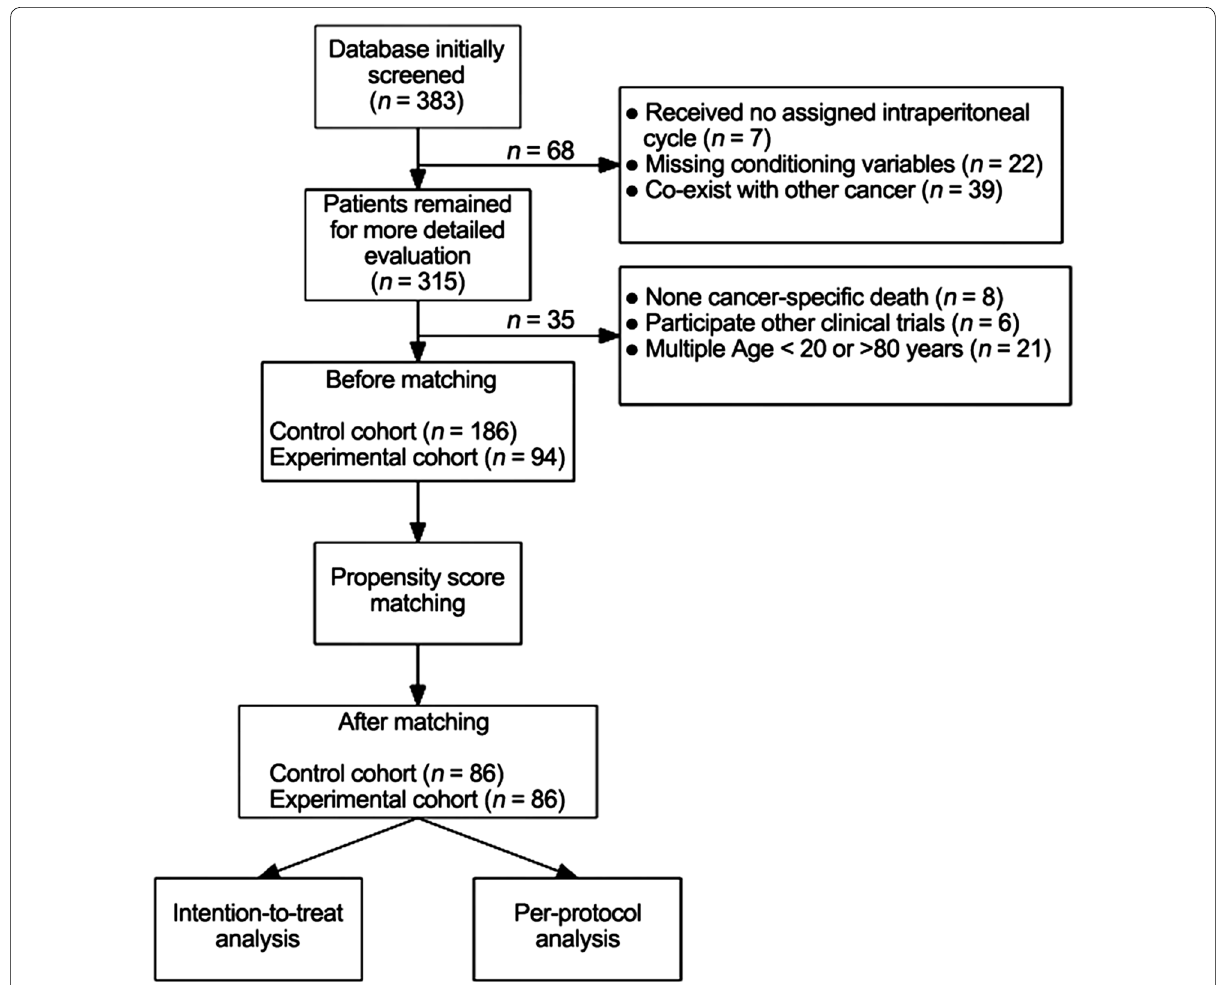
Fig. 1 Flow chart of the screening and propensity score‑matching